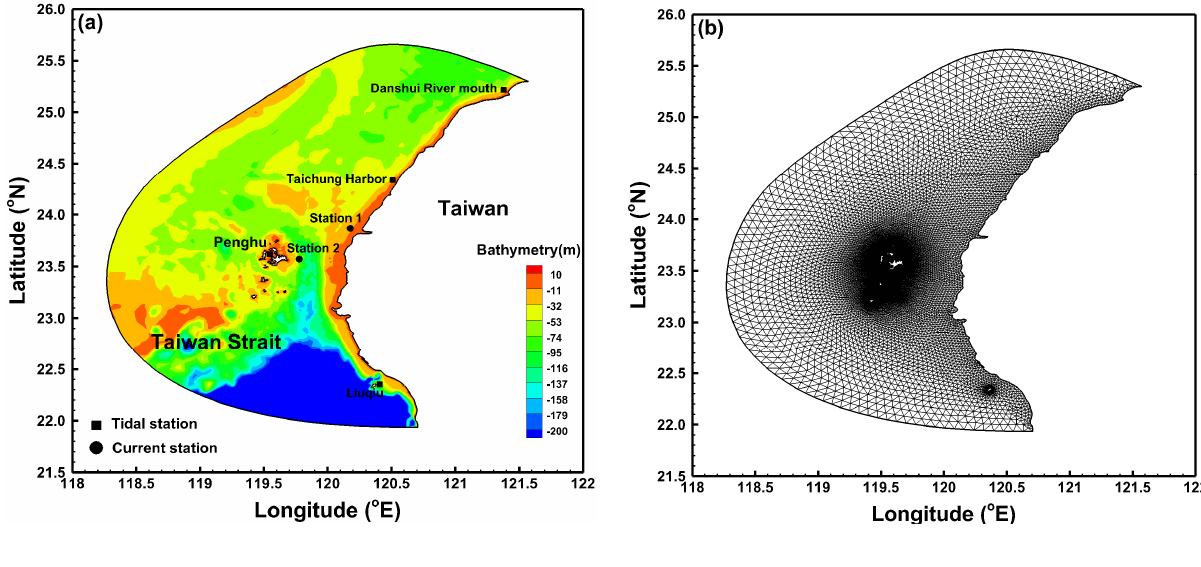
Figure 2. ( a ) Bathymetry of the study area; and ( b ) the unstructured grid for computational domain. Note that negative values in the bathymetry scale are below mean sea level and positive values are above mean sea